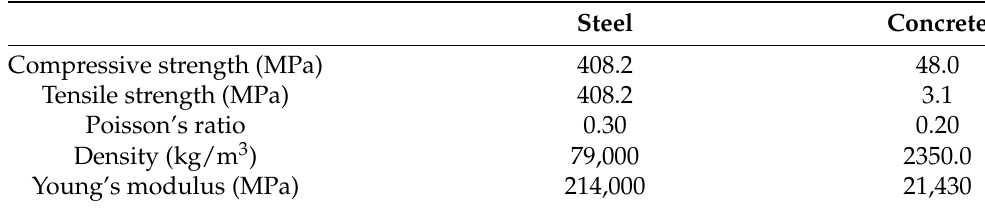
Table 2. Material constants used in the analysis.